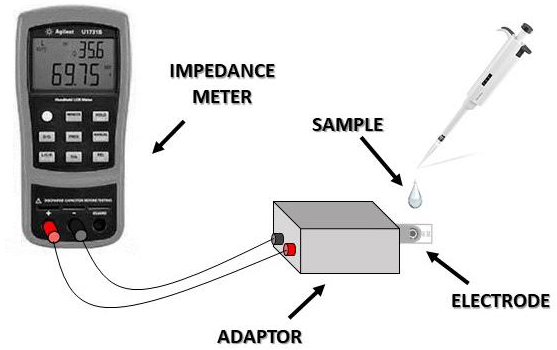
Figure 2. Impedance-based biosensor assembly.